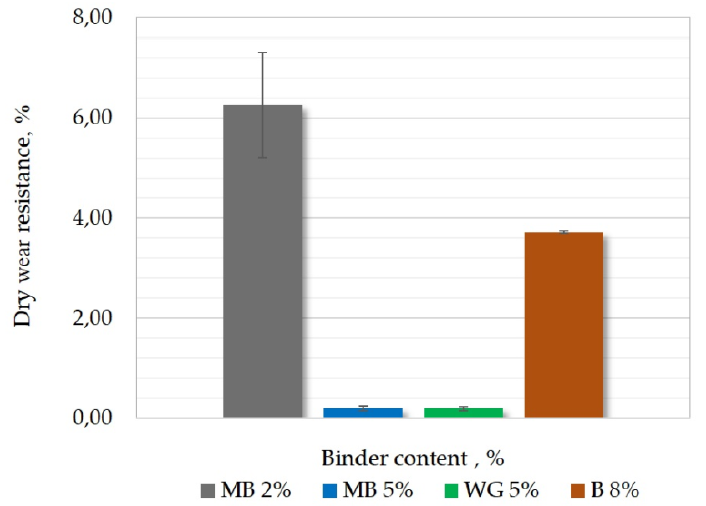
Figure 11. Results of dry wear resistance measurements of different molding sands.